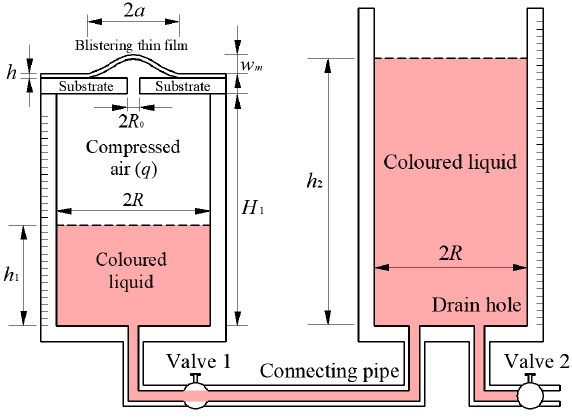
Figure 3. Schematic view of the improved experimental setup for pressurized blister test.